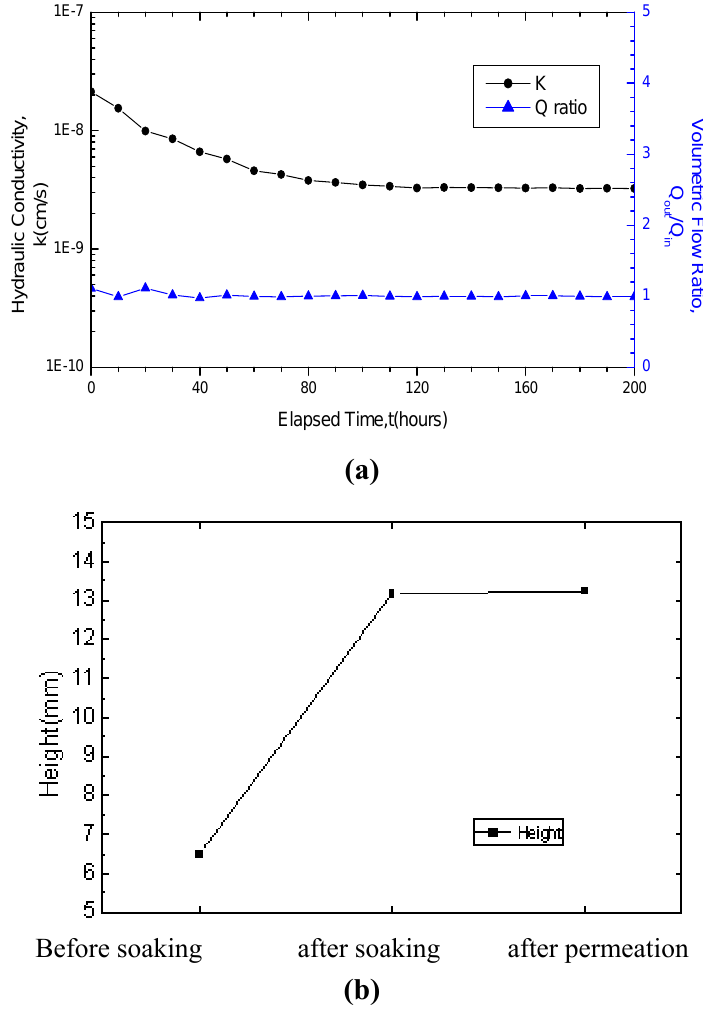
Figure 1. Test results for GCL specimens permeated with water: ( a ) variation in hydraulic conductivity; ( b ) variation in